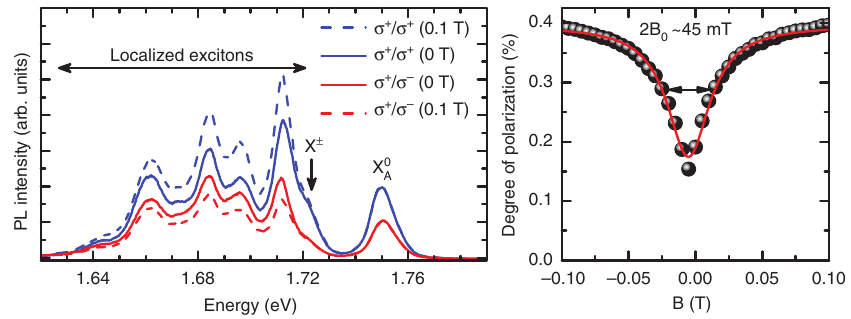
at B = 0 and when B = 100 mT is applied perpendicular 2 monolayer shows a strong 2